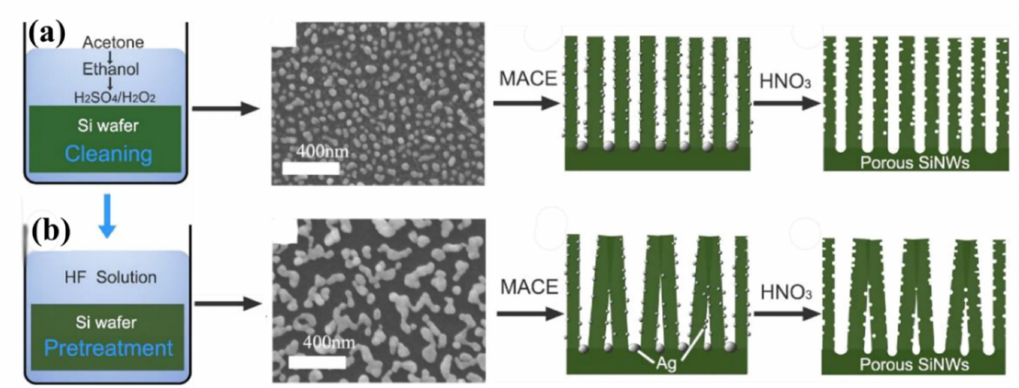
Figure8. Schematicillustrationoftheetchingmodelsfortheformationof( a )separatingand( b )bundling SiNWs using MACE process. The SEM micrographs show in the part ( a ) uniform Ag nanoparticles formed on the untreated hydrophilic substrate and in the part ( b ) irregular Ag nanoflakes formed on the HF pretreated-induced hydrophobic substrate. Reproduced from [111], with permission